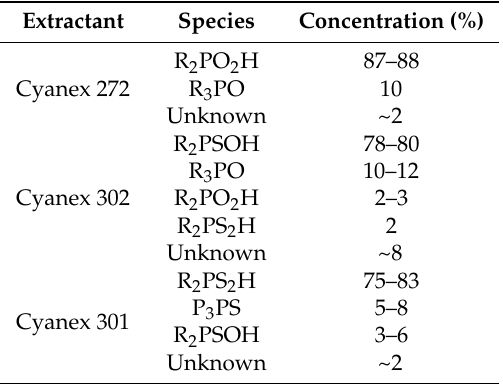
Table 2. Components of Cyanex 272, Cyanex 302 and Cyanex 301